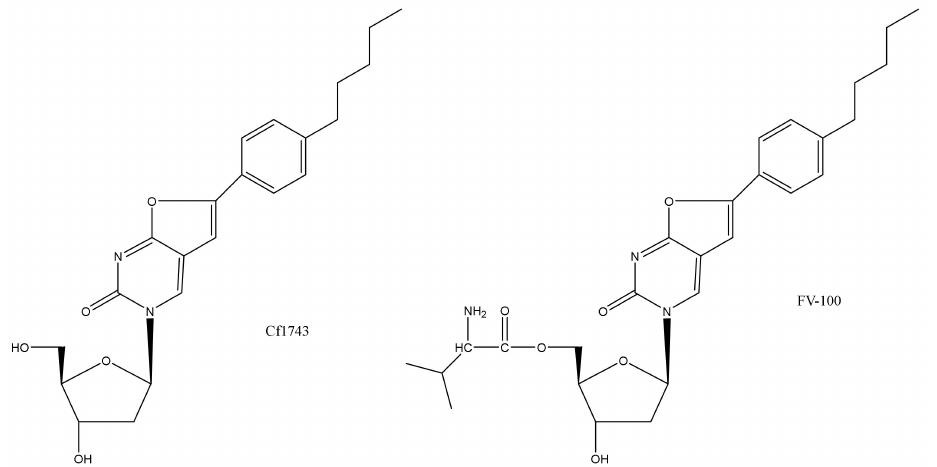
Figure 1. Chemical structures of Cf1743 and FV-100.